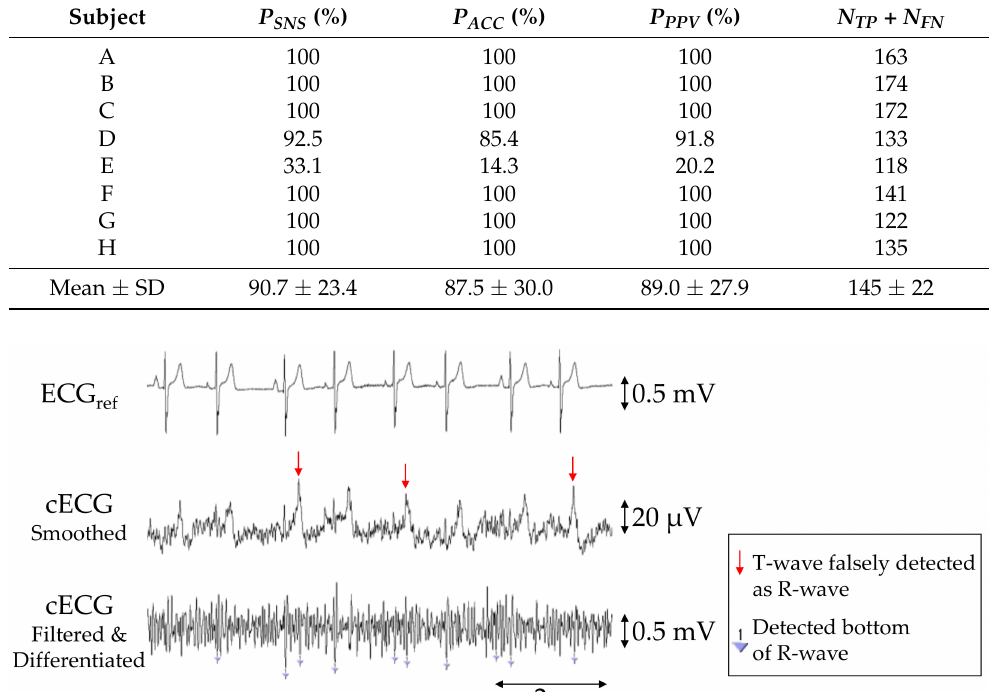
Table 2. Sensitivity ( P SNS ) (%), accuracy ( P ACC ) (%), and positive predictive value ( P PPV ) (%) of R waves.